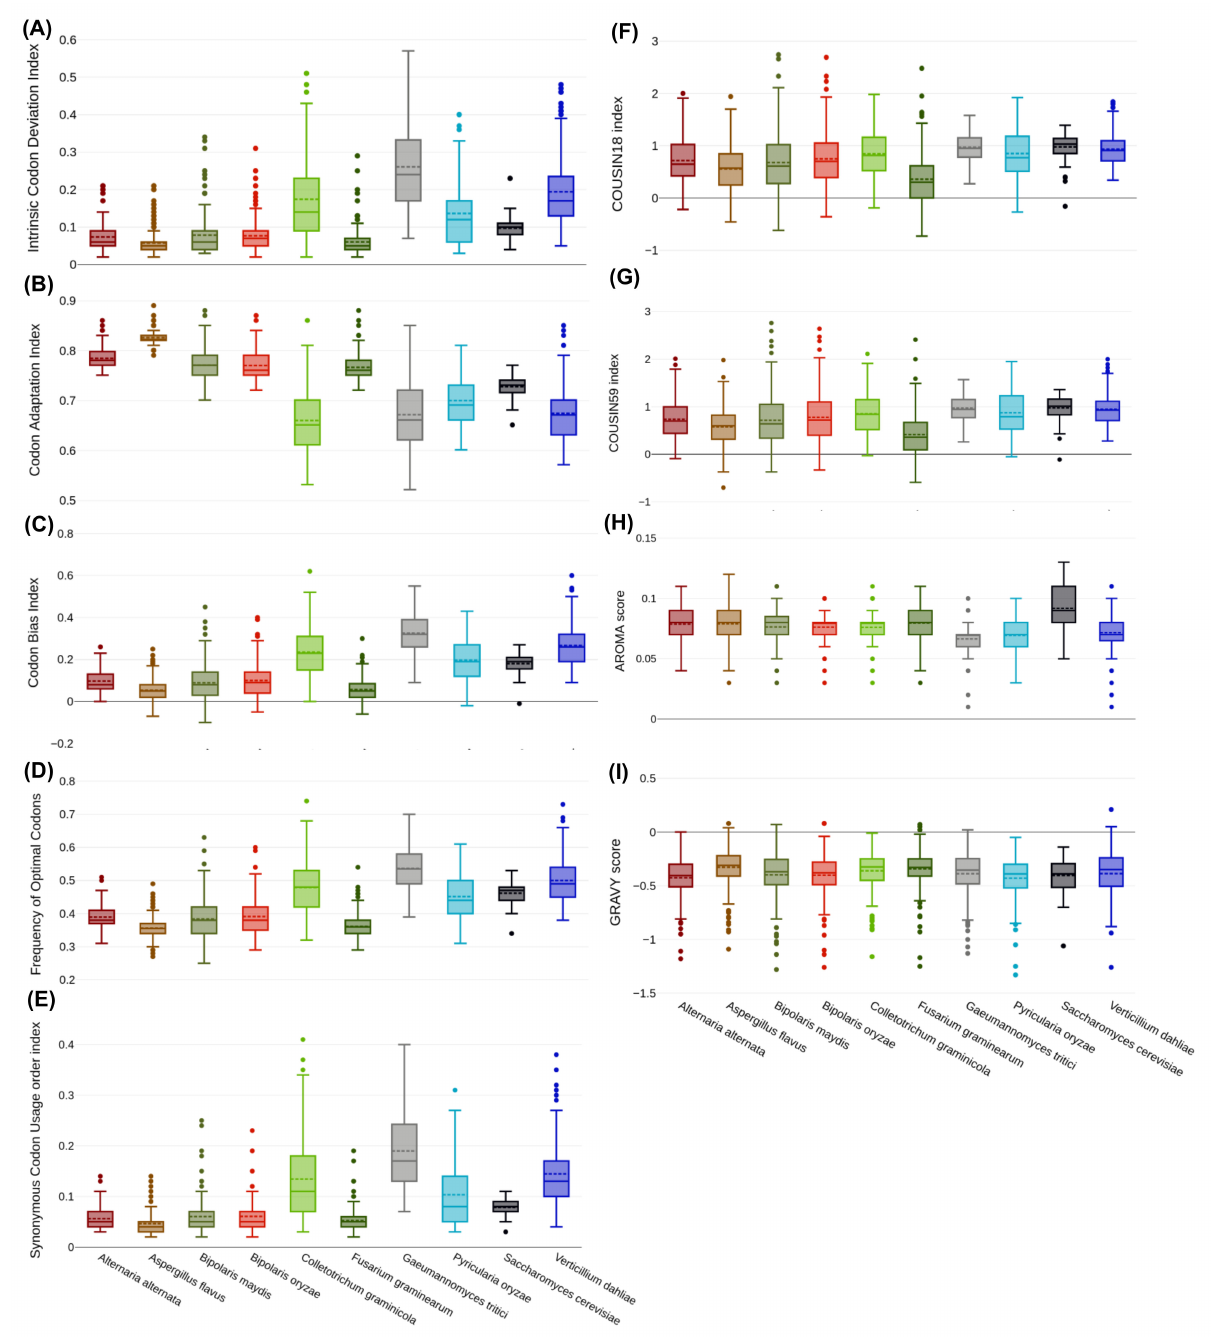
Figure 4. The box and whisker plots depict the descriptive statistics of various codon bias parameters. Each box plot with distinct colour indicates one species. Brick red, mustard yellow, olive, red, light green, dark green, grey, sky blue, black, and purple colour represent A. alternata , A. flavus , B. maydis , B. oryzae , C. graminicola , F. graminearum , G. tritici , P. oryzae , S. cerevisiae , and V. dahliae , respectively. The diagrams include: ( A ) ICDI, ( B ) CBI, ( C ) CAI, ( D ) FoP, ( E ) SCUO, ( F ) COUSIN18, ( G ) COUSIN59, ( H ) AROMA score, and ( I ) GRAVY